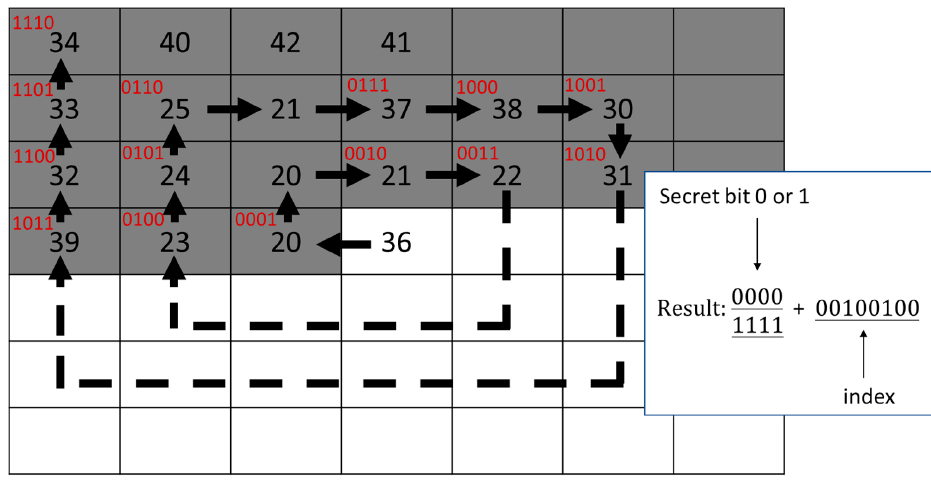
Figure 12. Embedding example 2: incompressible index.